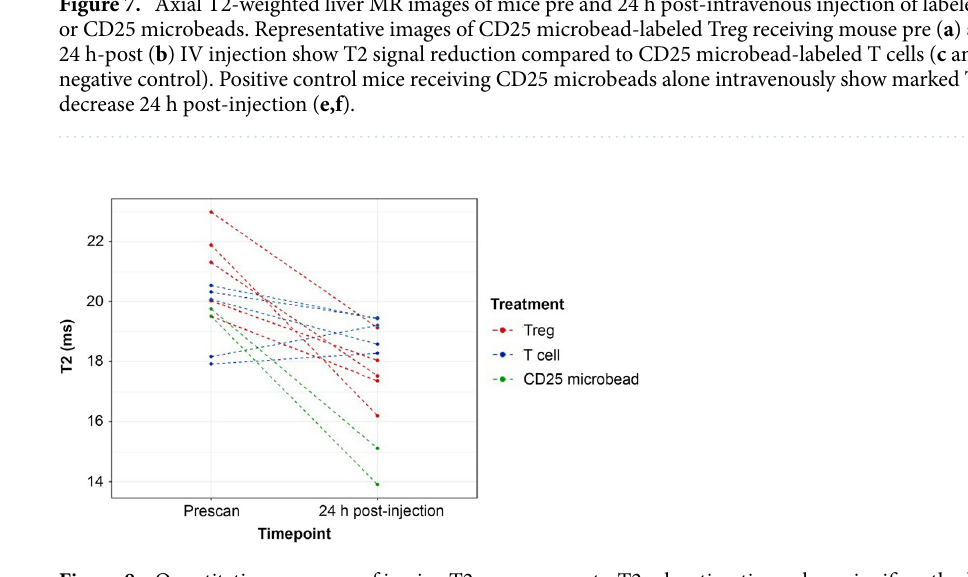
Figure 8. Quantitative summary of in vivo T2 measurements. T2 relaxation times show significantly shorter T2 values in Treg-receiving mice 24 h post-injection compared to prescan ( p = 0.007). Contrarily, T cell-receiving mice show no differences in T2 ( p = 0.44). Positive control mice receiving CD25 microbeads alone show drastic T2 reduction as expected. The difference between Treg and T cell receiving mice is also significant ( p = 0.029). Data are displayed as T2 means for each animal (9 measurements per animal per data